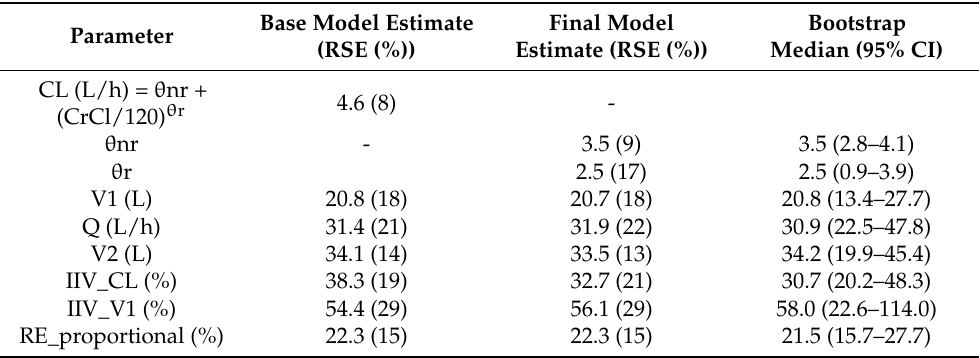
Table 3. Base and final population pharmacokinetic models estimates, shrinkage a values and bootstrap